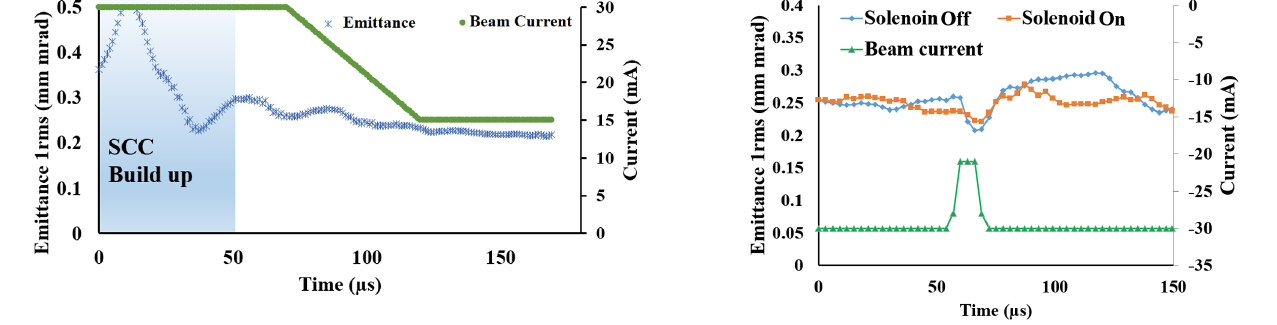
FIG. 13. H − transversal emittance evolution under SCC when the beam intensity decays linearly. FIG. 14. Emittance evolution under SCC when the beam intensity decay for a short period of